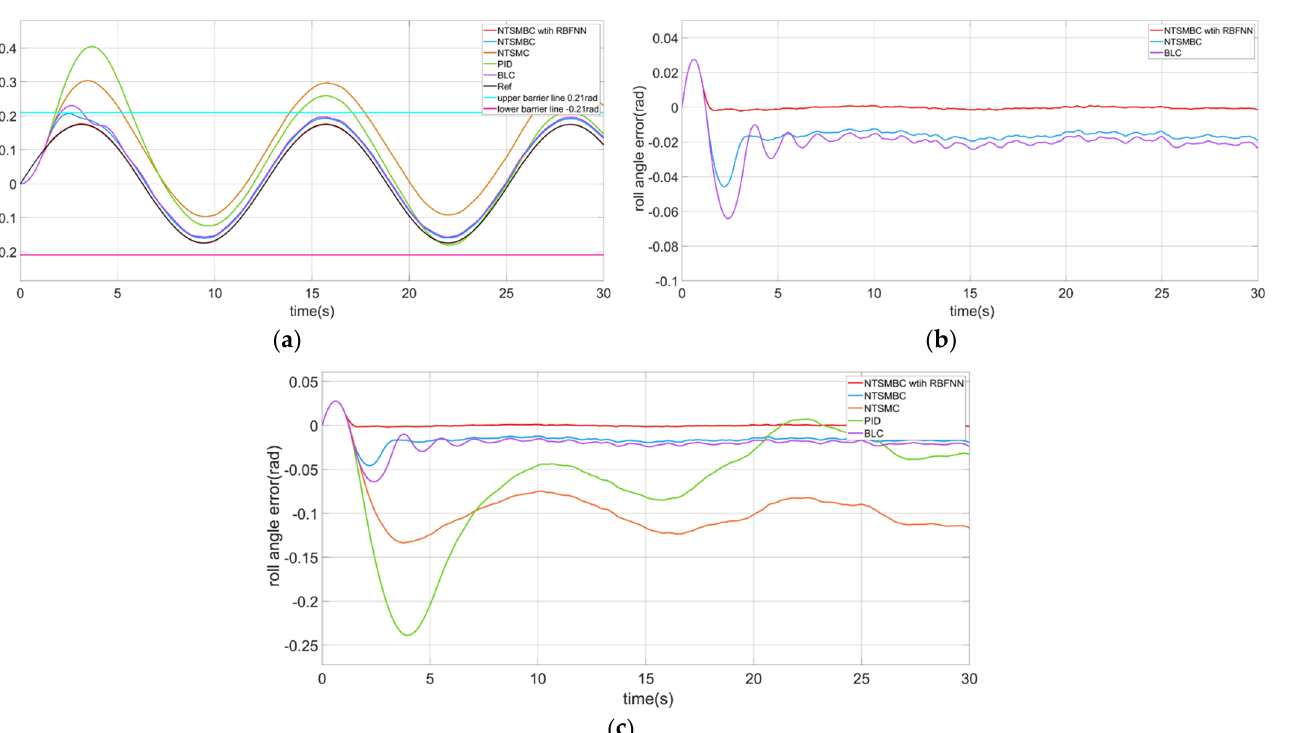
Figure 12. The output of the roll angle RBFNN. The red line is the output of the RBFNN, which could approximate the random lump disturbance with a mean value of −1.